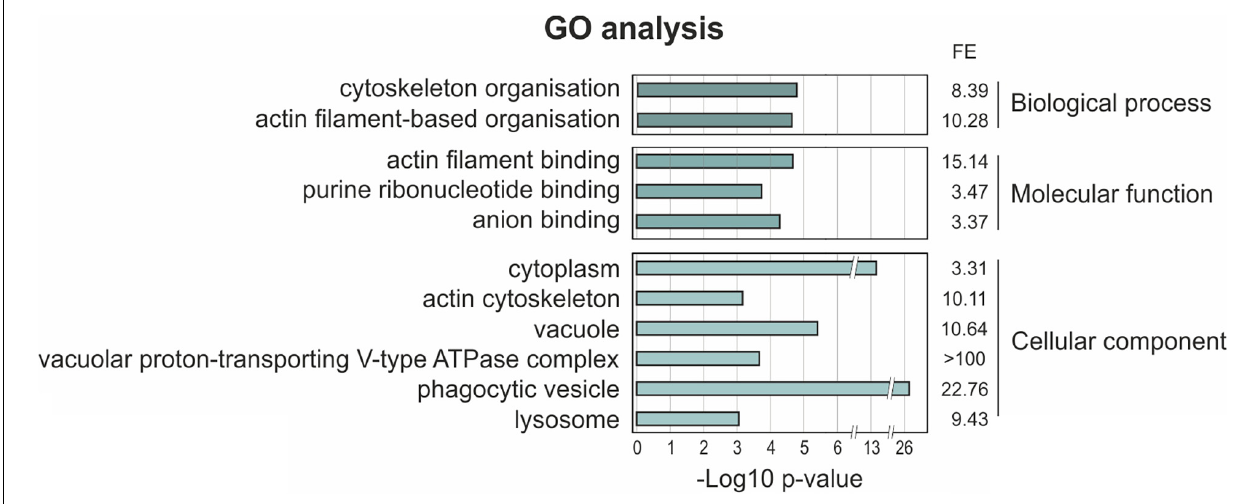
FIGURE 7 | Gene ontology (GO) term enrichment analysis of proteins identified as putative interaction partners of UBXD9 in at least two experimental setups. The proteins, which were identified in at least two experimental approaches (listed in Table 2 ), were used as input for GO analysis. The analysis was performed with PANTHER version 15.0. For the enriched categories –Log10 p -value and fold enrichment (FE) are